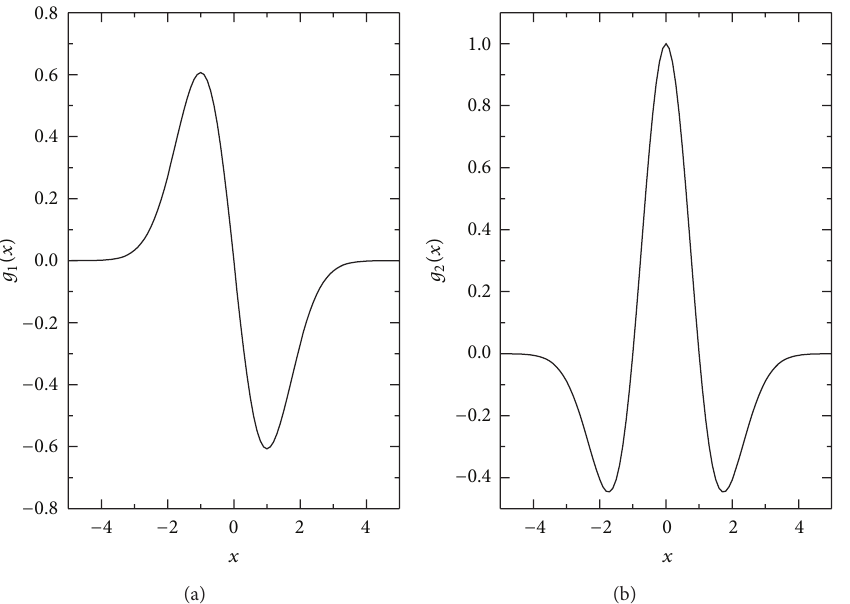
Figure 1: (a) First derivative and (b) second derivative (Mexican hat wavelet) of Gaussian function.